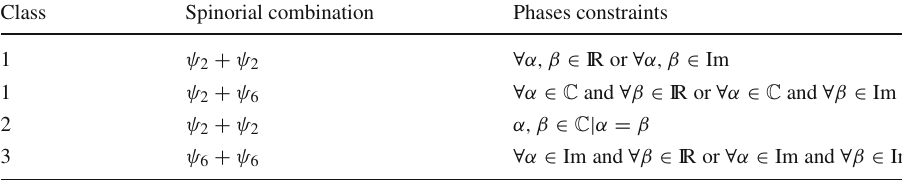
Class Spinorial combination Phases for the Lounesto’s regular sector